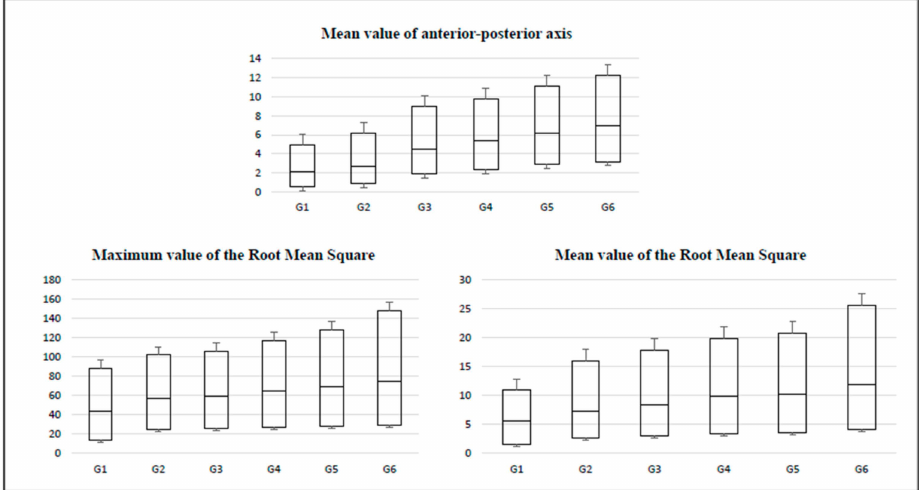
Figure 3. Box charts for the monopodal balance test with closed eyes by age